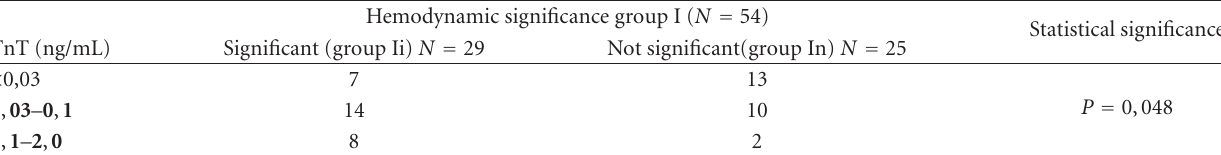
Table 3: Troponin T concentration categories in dependence of heart defect hemodynamic significance.